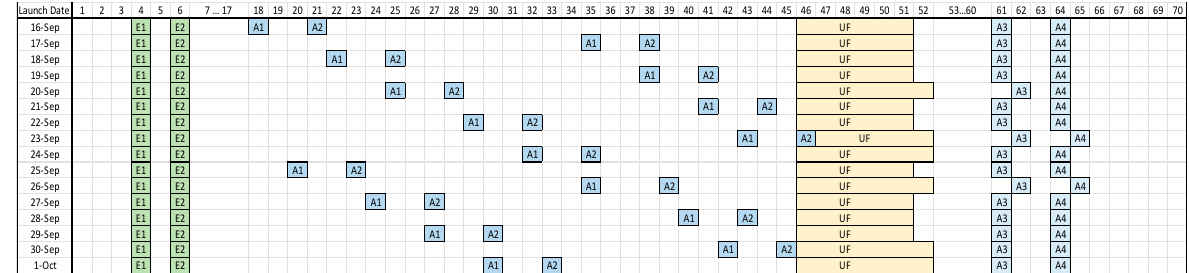
Figure 1. Table of Ascent Plans for a 16-day Launch Cycle. For each prospective launch date for Landsat 9, Landsat 8 can be in a different position in its orbit, requiring a different Ascent Plan. Because Landsat 8 has a 16-day Repeat Ground Track, the Flight Dynamics team created 16 Ascent Plans. This figure begins on 16 September 2021 because that was the planned launch date, until circumstances forced a skip until 27 September 2021. This figure indicates possible Engineering Burns (E1-2), Ascent Burns (A1–4) and Under-fly periods (UF) to meet mission constraints and guidelines in Table 2.